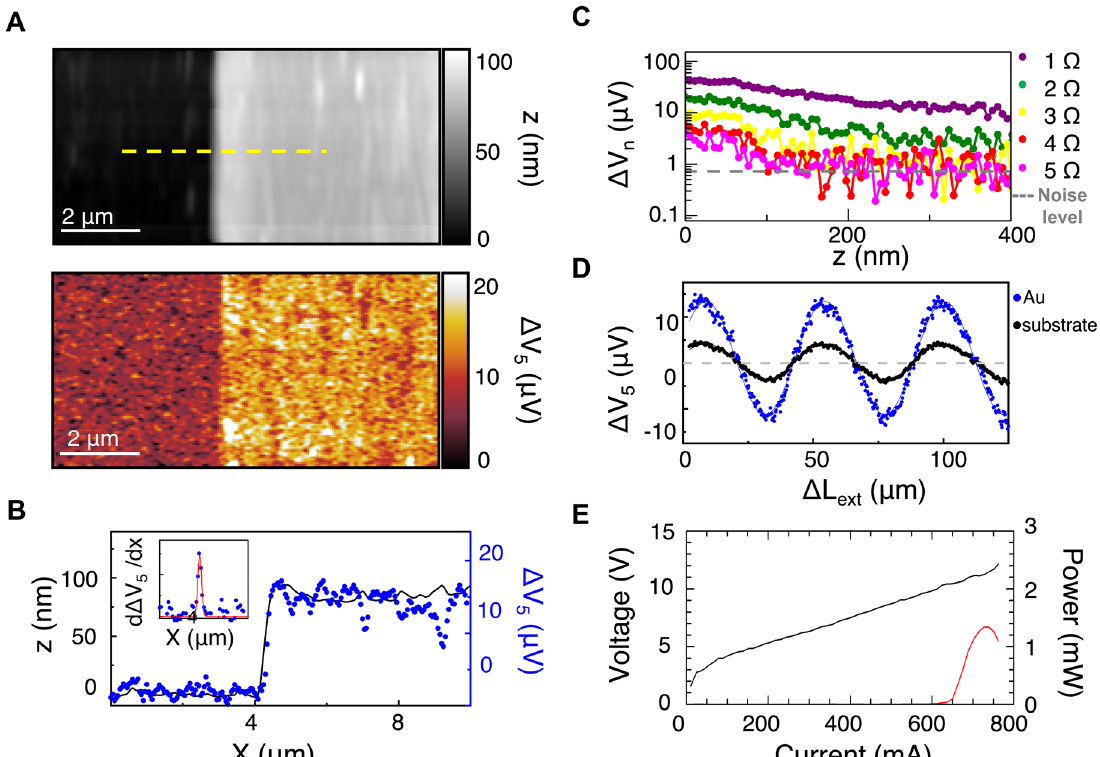
Figure 4: Near-field self-mixing measurements in single mode operation. (A) (top panel) Sample topography ( z ) at the interface between 100 nm Au marker and undoped Si substrate and (bottom panel) self-mixing signal Δ V 5 demodulated at the fi fth harmonics of the tapping frequency ω t , collected with a speed of 2 μ m/s corresponding to 6 ms per pixel; (B) line-pro fi le along the yellow dashed line in panel (A) reporting the topography (black line-left axis) and the Δ V 5 signal (blue circles-right axis),includingasinsettheestimationofthespatialresolution(equalto120nm)fromtheGaussian fi t(redline)ofthe fi rstderivativeofthe Δ V 5 (blue circles) at the sample edge; (C) approach curves for the self-mixing signal Δ V n demodulated at the different harmonics order n ; (D) self- mixing signal demodulated at the fi fth harmonics as a function of the external cavity length L ext at fi xed point on the sample corresponding to Au (blue) and substrate (black) reporting data (circles) and sinusoidal fi t (lines); (E) current-voltage and light-current characteristics acquired while driving the random laser in continuous wave at 10